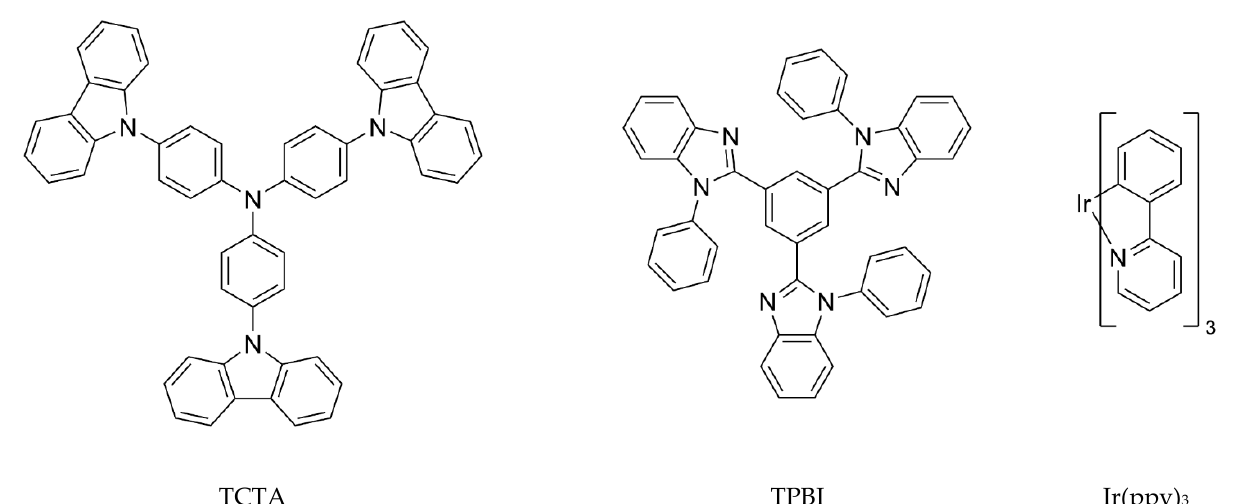
Figure 1. Chemical structures of cohost and guest molecules. TCTA and TPBI are, respectively, hole and electron transporting materials and constitute the exciplex-forming cohost. Ir(ppy) 3 is a typical green phosphorescent guest.